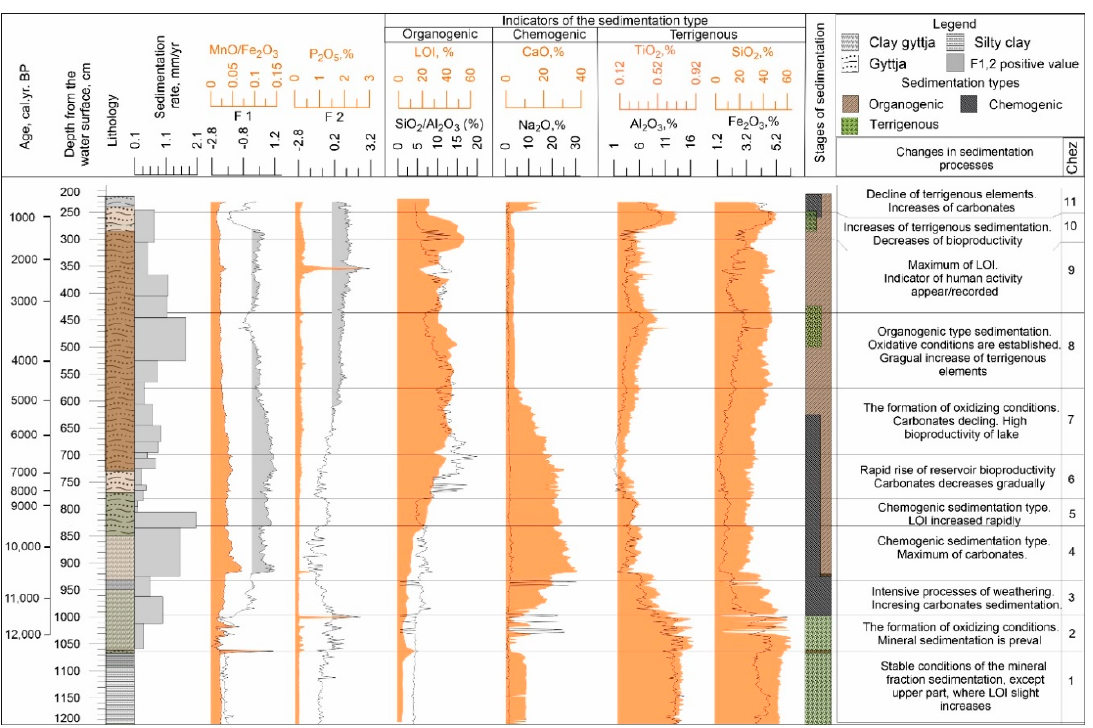
Figure 4. Results of the geochemical analysis.